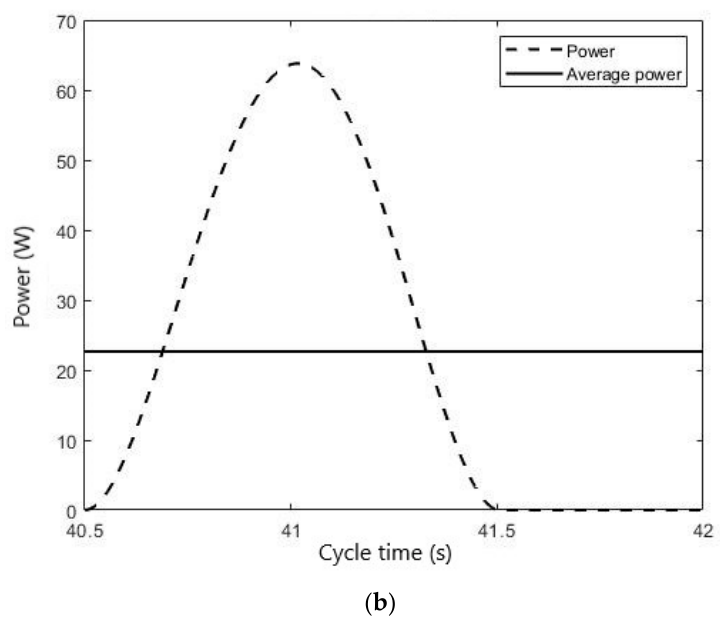
Figure 16. Wheelchair speed ( a ) and user’s power ( b ) in a complete cycle during the steady-state phase.